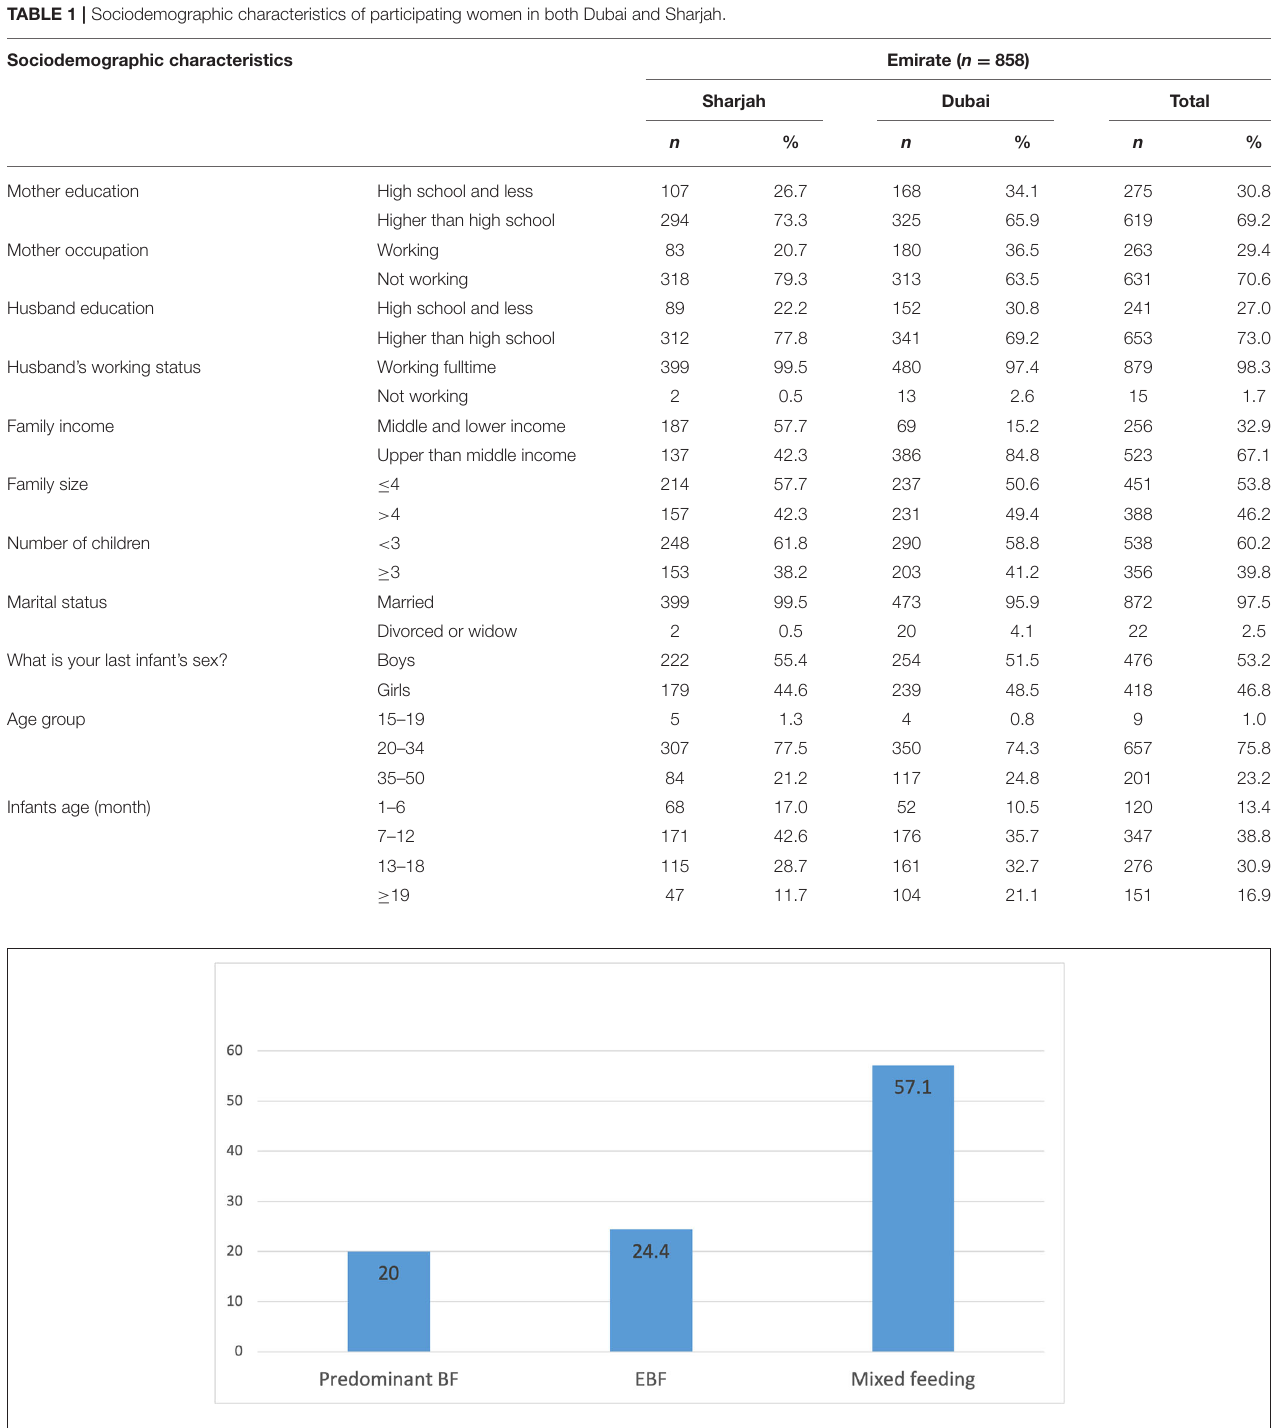
of breastfeeding indicated by “exclusive and mixed formula breastfeeding” among Emirate mothers are in the overall population, before and during the pandemic, is assessed by